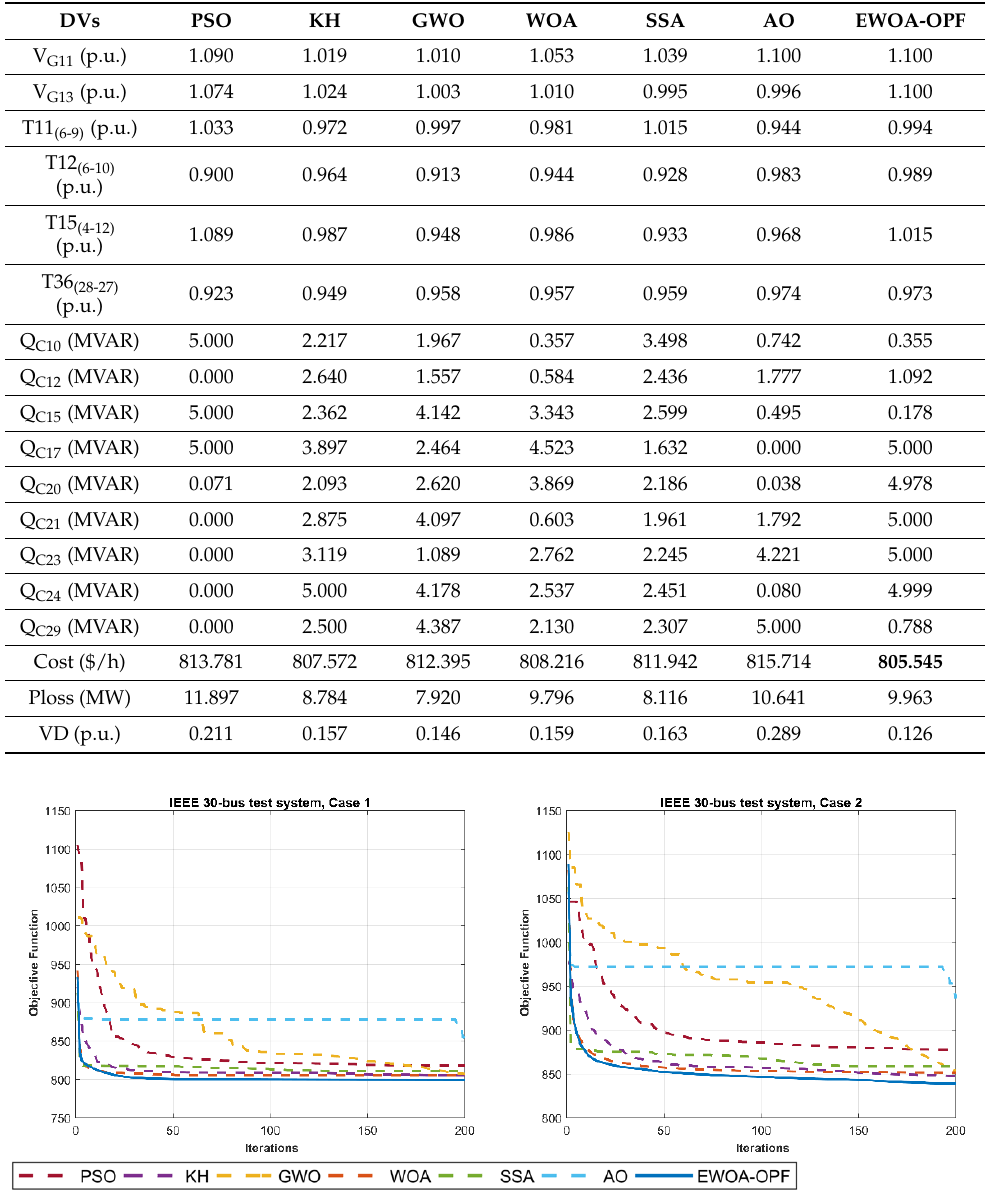
Figure 6. Curves for all test systems on Cases 1 and 2.